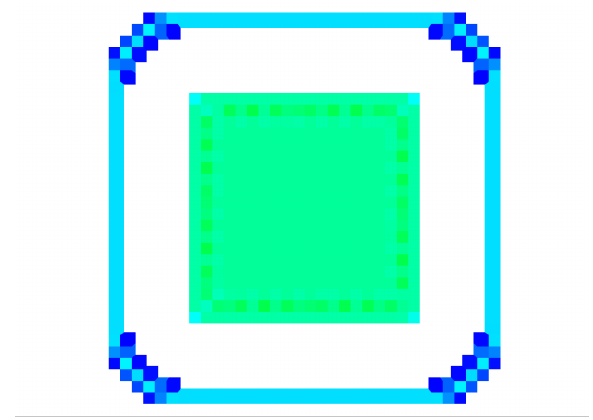
Figure 5. Activated voxel elements of a first layer of a 20 × 20 × 20 mm cube including volume assignment.